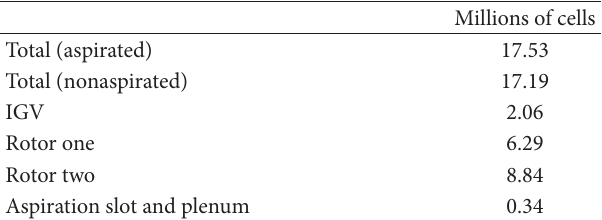
T 2: Number of cells per